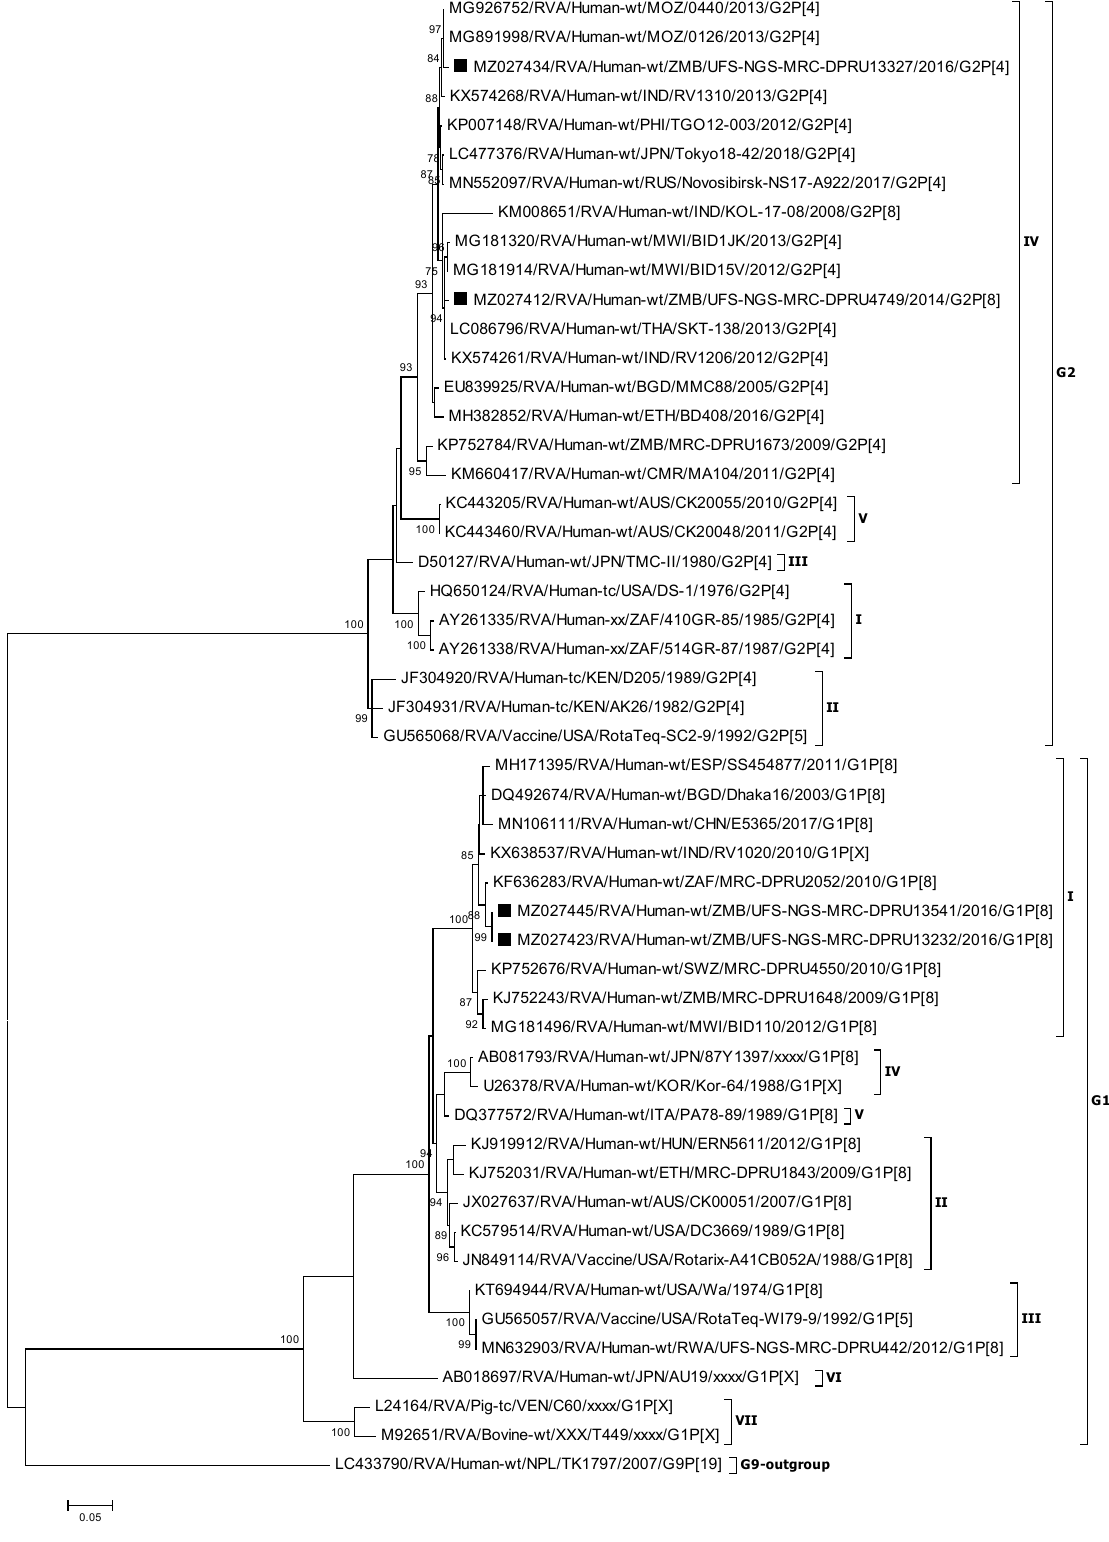
Figure 1. VP7 phylogenetic tree of the Zambian G1 and G2 strains indicated by black squares along with representative strains. Phylogenetic analysis was conducted using the maximum likelihood method with bootstrap values of 1000 replicates. The scale at the bottom indicates the number of nucleotide substitutions per site. Percent values of bootstrap values greater than or equal to 70 is indicated on the branch nodes.